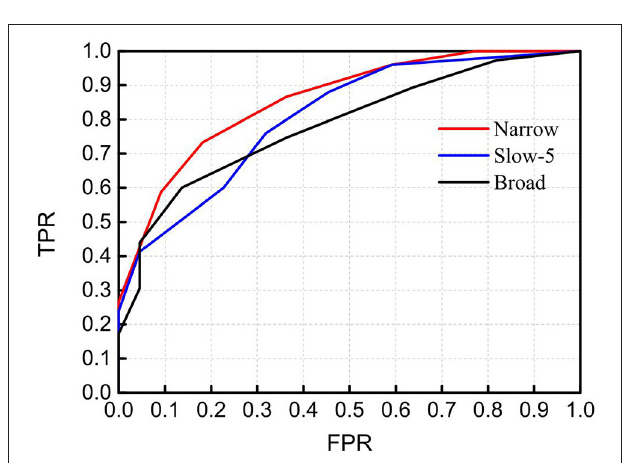
FIGURE 5 | Receiver operating characteristic (ROC) curves obtained by using RSFC as discriminative features in the narrowband of 0.01–0.02Hz (Narrow), Slow-5 band (Slow-5), and broadband of 0.009–0.08Hz (Broad). The RSFC for each band is the mean of RSFC averaged over channel pairs showing significantly different connectivity between the ASD and TD groups. AUC (Narrow) = 0.867, AUC (Slow-5) = 0.817, and AUC (Broad) = 0.793. FPR, false-positive rate; TPR, true-positive